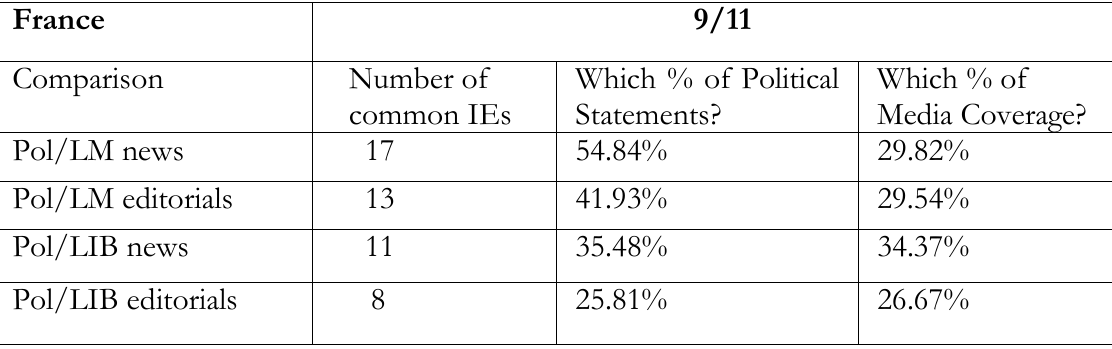
Table 6. Comparisons between political statements, first page news, and editorials in